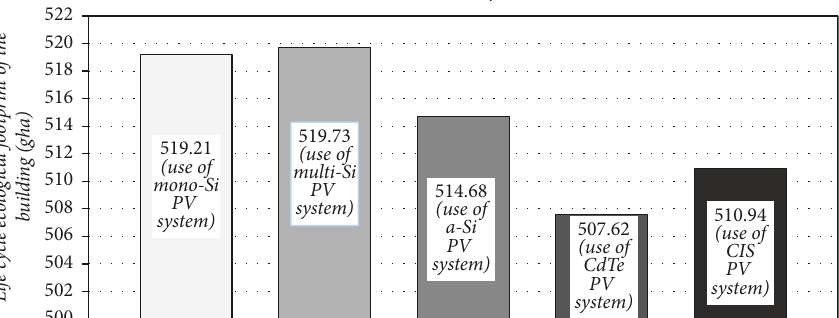
Figure 10: The EF T of building with different types of PV modules system installation. Table 15: The combined effect of materials and rooftop solar PV system on the EF Power